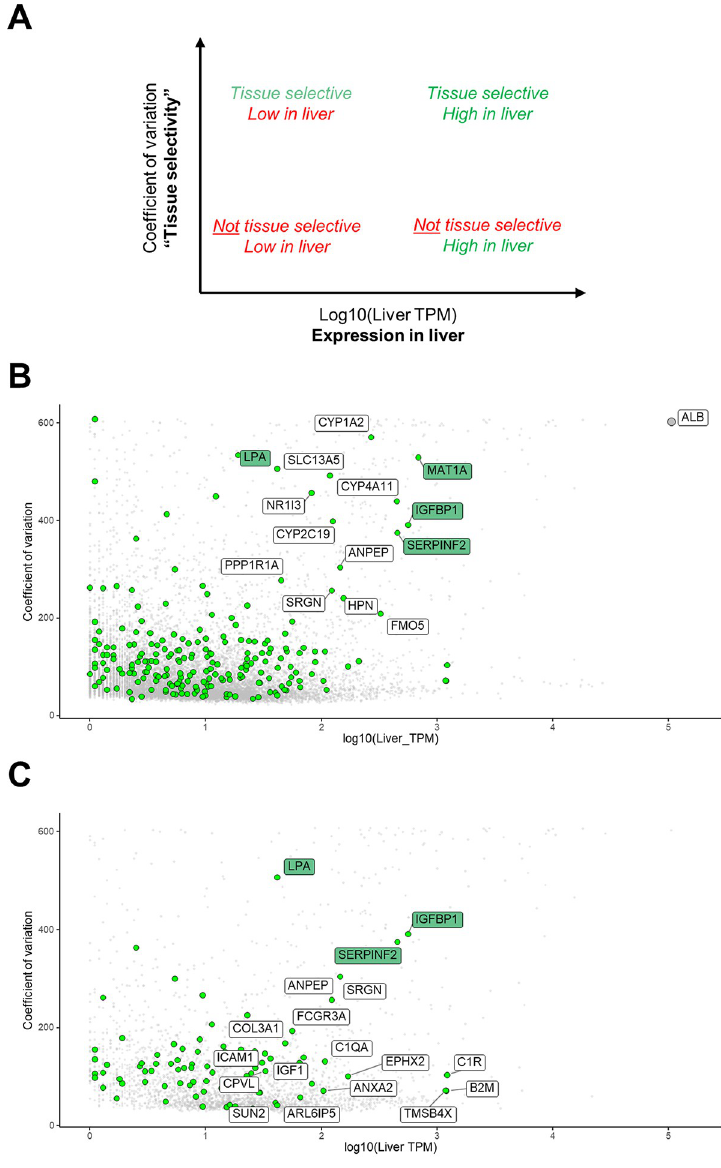
Fig 4. Selection of candidate genes with biomarker potential. (A) Evaluation of gene expression by coefficient of variation across all tissues (y-axis) versus liver tissue expression levels (x-axis, TPM). A high coefficient of variation with respect to tissue selectivity in combination with high liver expression (towards the top right corner) suggests liver- selective expression. (B) Coefficient of variation versus liver tissue expression levels for all identified genes (grey dots) including all DEGs (green dots) as well as for albumin. (C) Coefficient of variation versus liver tissue expression levels for all identified genes (grey dots) including all DEGs (green dots) that were predicted as secreted. Highlighted genes (green boxes), LPA (lipoprotein A), IGFBP-1 (insulin-like growth factor-binding protein 1), SERPINF2 (serpin family F member 2) and MAT1A (methionine adenosyltransferase 1A), were selected and evaluated as gene biomarker candidates of NAFLD. Abbreviations: ALB, albumin; DEGs, differentially expressed genes; NAFLD; non-alcoholic fatty liver disease; TPM, transcript per million.